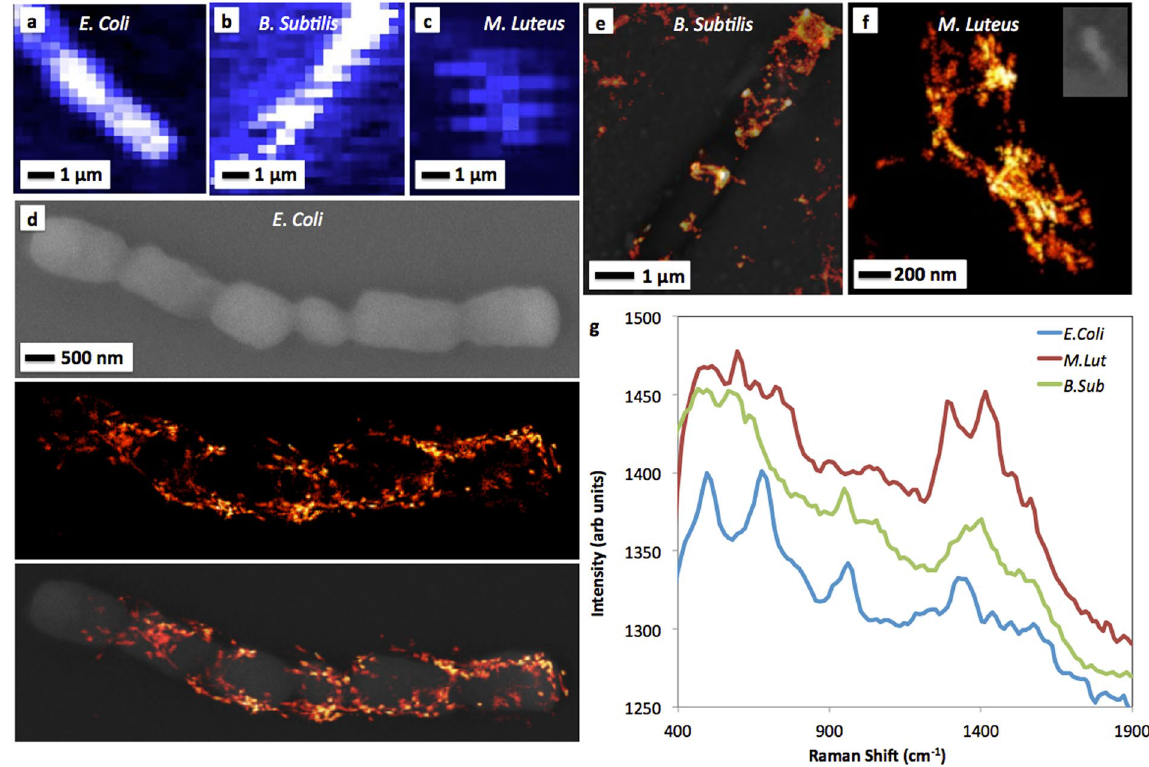
Figure 3. Comparison of diffraction limited laser point scans, SEM, and STORM images. ( a ) Laser scan image of E. Coli bacteria, ( b ) B. Subtilis bacteria, and ( c ) M. Luteus bacteria samples. ( d ) Panel of E. Coli images depicting (top) an SEM image of the bacteria sample, (middle) a STORM image of same sample, and (bottom) an overlay of the two. ( e ) STORM images of B. Subtillis overlayed with an SEM of the same region. ( f ) A STORM image of M. Luteus cells with an inset of an optical microscope image showing the circular shape. ( g ) SERS spectra collected from the laser points scans in panels ( a ) through ( c ) of the various bacteria